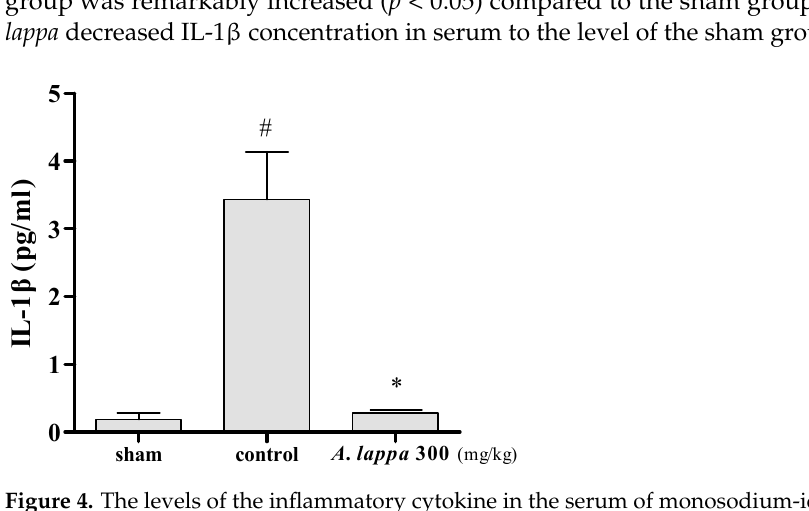
Figure 4. The levels of the inflammatory cytokine in the serum of monosodium-iodoacetate (MIA)- induced OA rats. Serum IL-1 β levels were measured using Rat Premixed Multi-Analyte Kit and Luminex MAGPIX analyzer. # p < 0.05 vs. sham, * p < 0.05 vs. control.